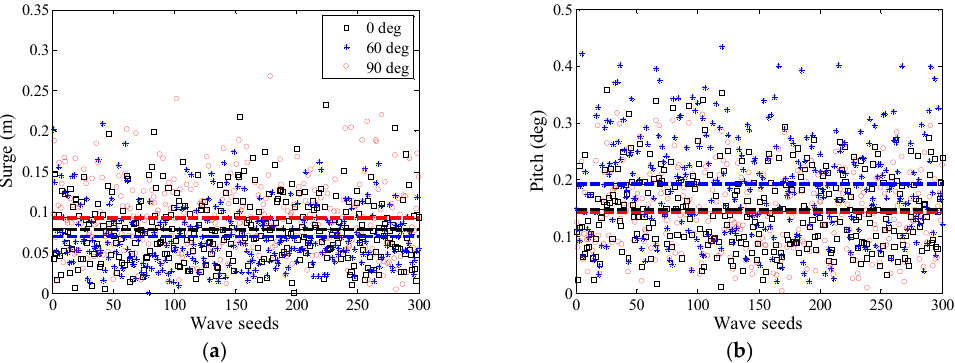
Figure 19. Second-order ( a ) surge and ( b ) pitch motion responses under the rated operational wave condition.